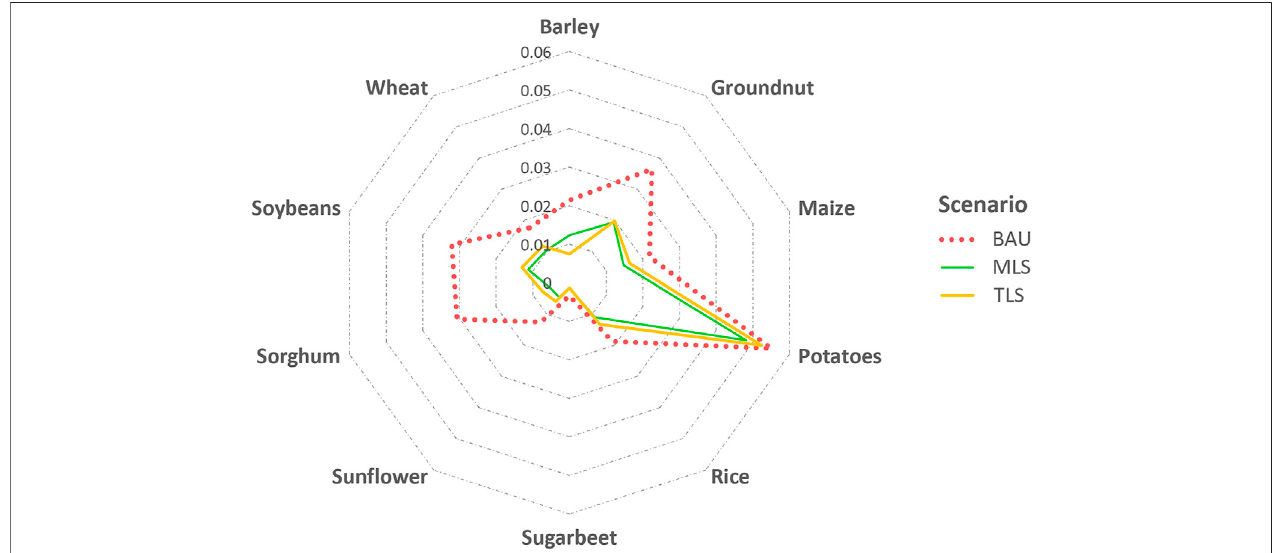
FIGURE 6 | Costs of energy production for the 10 crops considered (USD per Mcal of energy